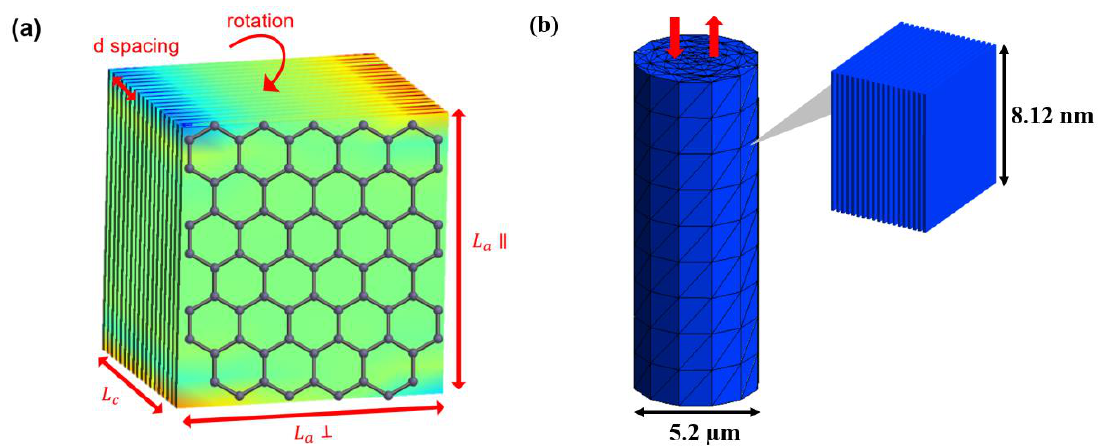
Figure 6. ( a ) Digitization of crystalline structure information; ( b ) Preliminary multiscale model for mechanical properties with RVEs, including crystalline structure.